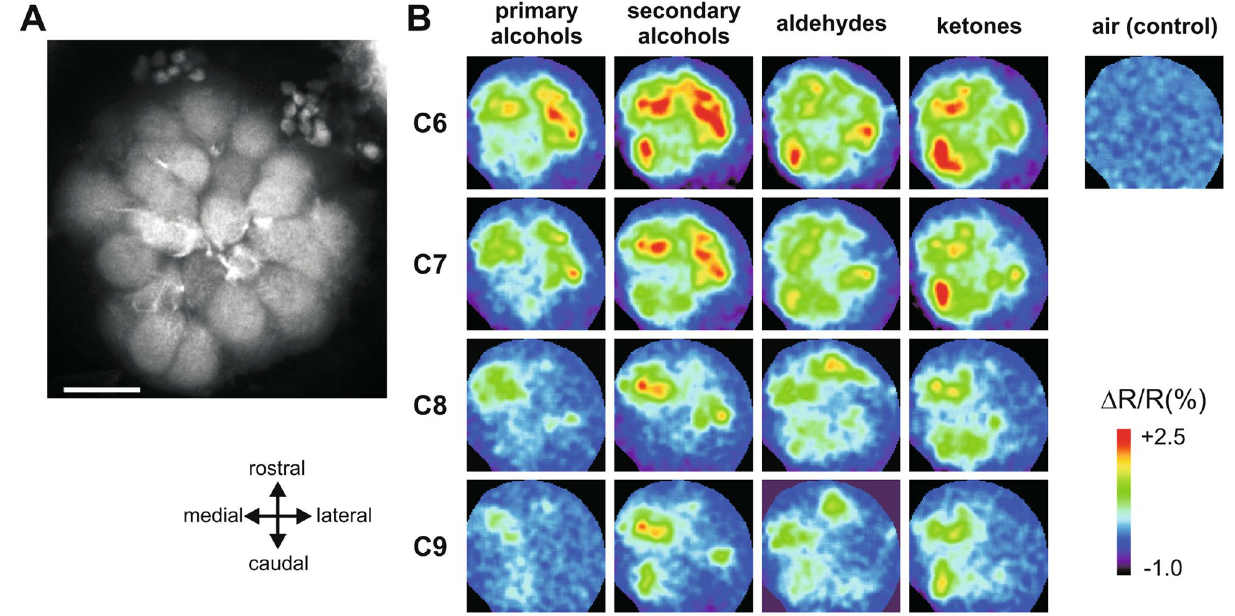
Figure 2. Odor-induced calcium signals from glomeruli innervated by the lateral antennal-lobe tract (l-ALT). ( A ) Confocal image (z-projection over 14 µm, from 6 to 20 µm depth) of the superior part of the AL after retrograde staining (using tetramethylrhodamine dextran) of l-ALT PNs. Fluorescence coming from dendrites of l-ALT PNs is clearly visible in all observed glomeruli. ( B ) Calcium signals in the AL evoked by a panel of 16 odorants varying systematically according to their carbon chain length (C6–C9) and their functional group (primary and secondary alcohols, aldehydes and ketones). Relative fluorescence changes (∆R/R%) are presented in a false-color code, from dark blue (no response) to red (maximal response). Different odorants induce different glomerular activity